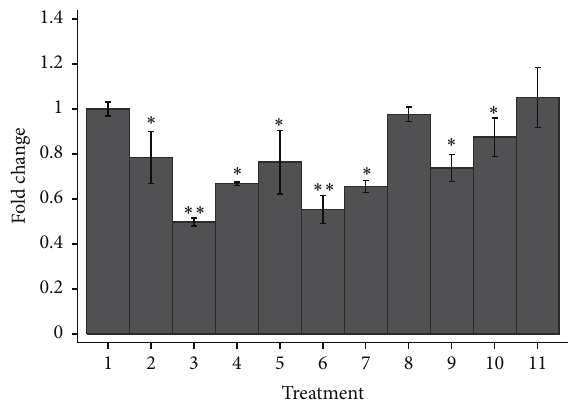
Figure 4: Cell viability expressed as mean fold changes and 95% confidence interval after treatment of hMSC-TERT20-CE8 which are clonal cells lines derived from stromal stem cell line and with the ability to form sarcoma-like tumours in mice. (1) Control, no treatment. (2) Doxorubicin 25 nM. (3) Doxorubicin 25 nM + dasatinib 5 𝜇 M. (4) Doxorubicin 25nM + erlotinib 5 𝜇 M. (5) Doxorubicin 50 nM. (6) Doxorubicin 50 nM + dasatinib 5 𝜇 M. (7) Doxorubicin 50 nM + erlotinib 5 𝜇 M. (8) Doxorubicin 50nM + afatinib 5 𝜇 M. (9) Dasatinib 5 𝜇 M. (10) Erlotinib 5 𝜇 M. (11) Afatinib 5 𝜇 M. The experiments were performed twice with at least a total of 6 replicates of each cell line. Significant results compared to the nontreated cells are marked with ∗ whereas significant results compared to the corresponding doxorubicin treatment are marked with nontreatment ∗∗ .